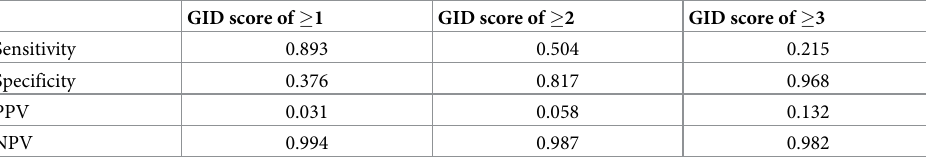
Table 3. Performance of GID score in predicting mortality in older patients with influenza in ED.